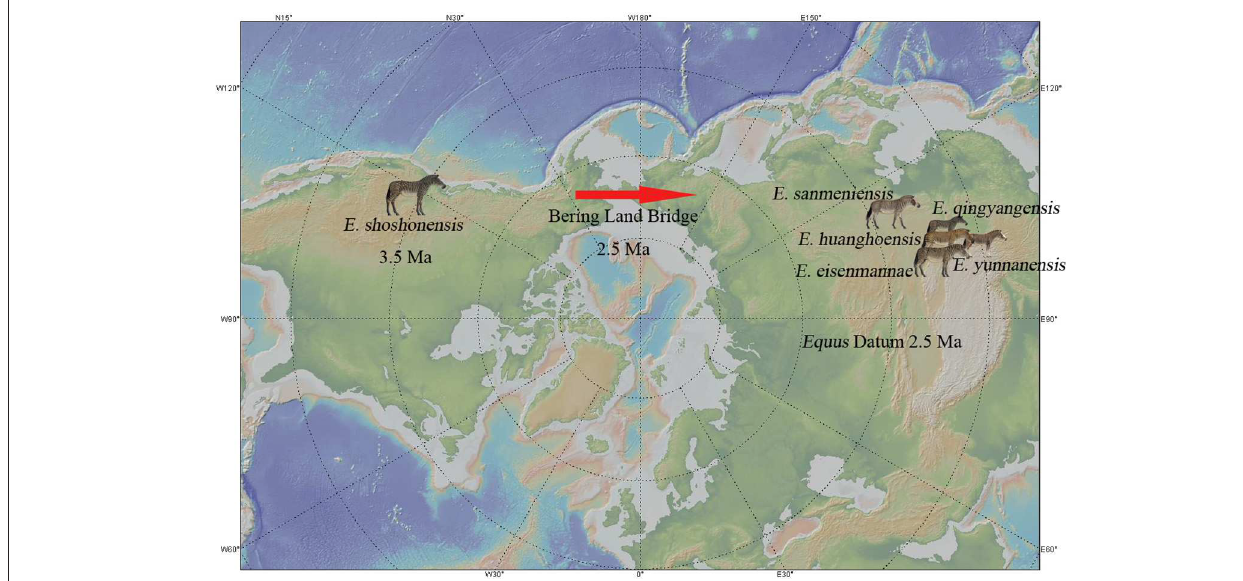
FIGURE 14 | Origin of Equus in North America and the Equus Datum in China.